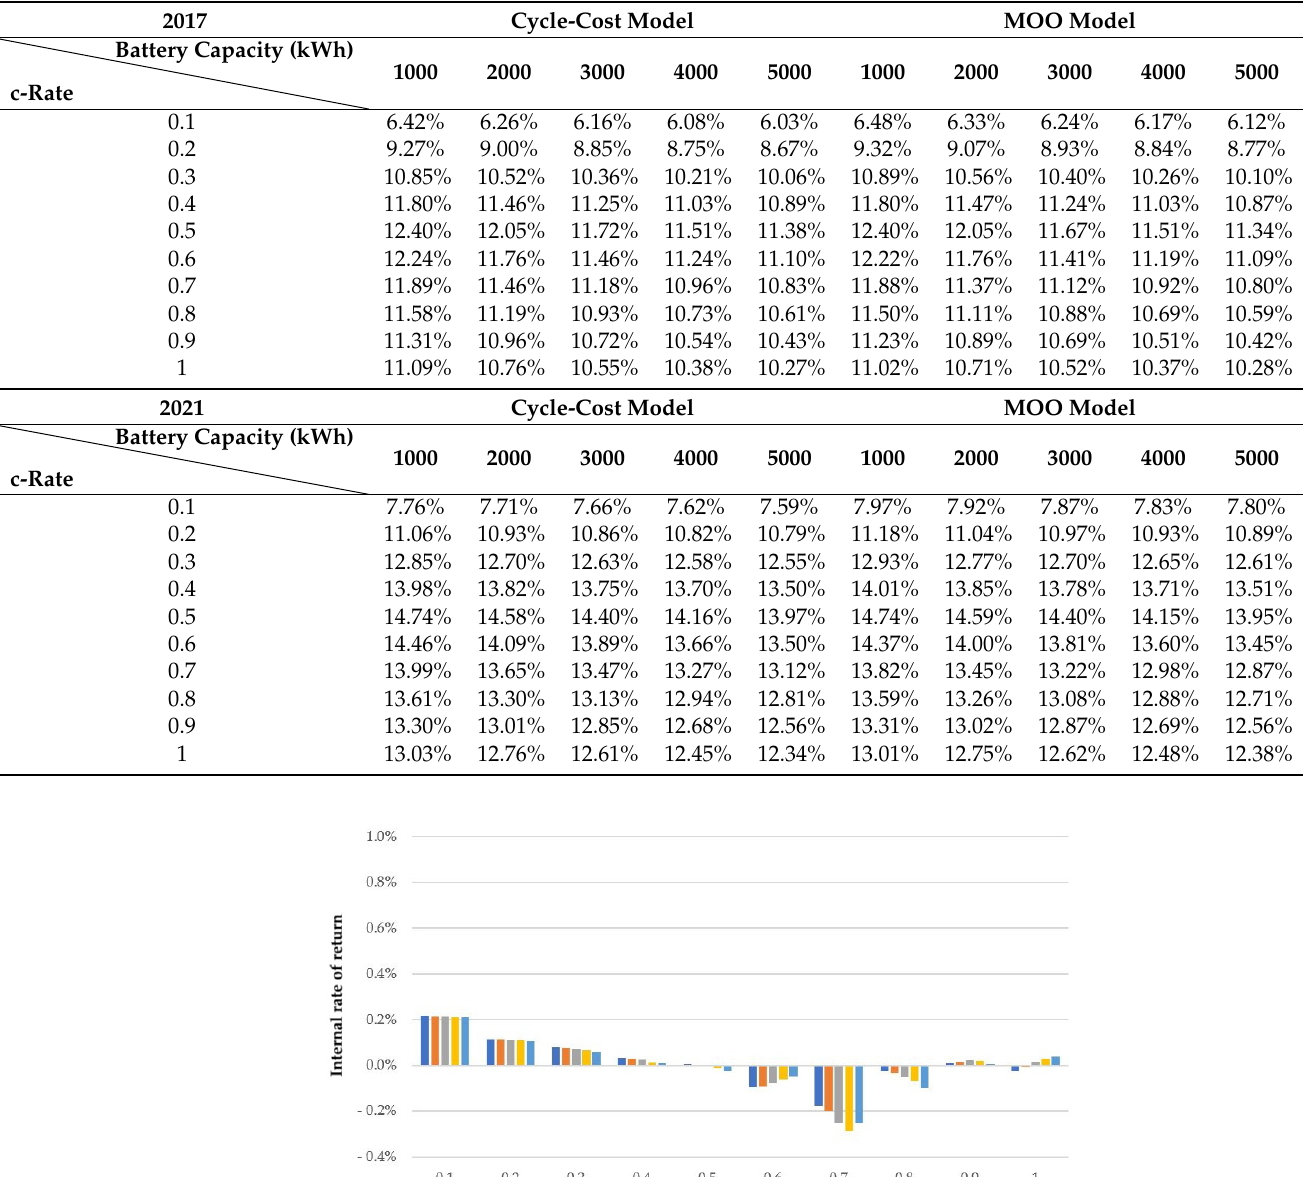
Table 3. Performance comparison (profitability measured by IRR) of CC and MOO.